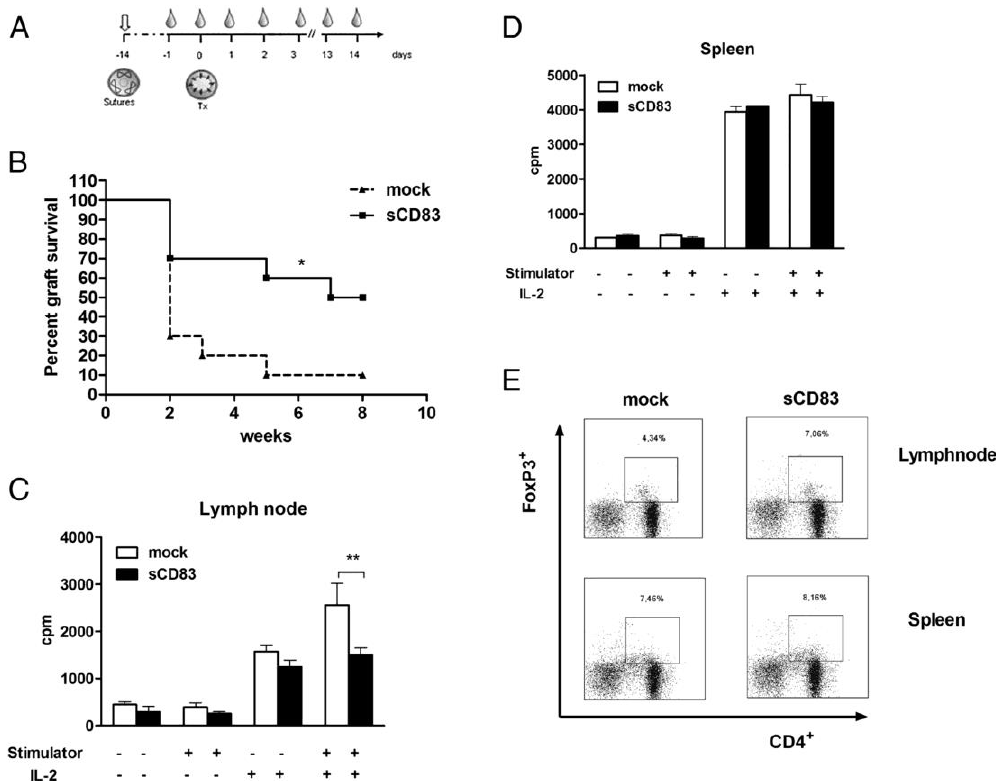
Figure 1. Topical application of sCD83 induces allogeneic graft tolerance, reduces proliferative response to donor alloantigen, and induces Foxp3 + regulatory T cells. ( A ) Experimental design and timescale of sCD83 administration. Sutures were placed in the cornea to induce inflammation (sutures) 14 d prior to transplantation (Tx). sCD83 (7.5 mg per 3 mL) was applied in the form of eye drops three times per day on indicated time points (drops). ( B ) The topical sCD83-treated group had a significantly improved graft survival compared with the mock-treated group ( p < 0.025; number of animals in each group: n = 10). * p < 0.05. ( C ) Draining lymph node cells from sCD83-treated animals showed a significantly reduced proliferation capacity in the presence of alloantigen and IL-2 compared with the mock-treated animals. Cells derived from sCD83-treated animals were still able to respond to exogenous IL-2, but to a lesser extent than mock-treated mice. Data are presented as the mean ± SE of triplicate samples. ( D ) This e ff ect could not be detected in restimulated splenocytes, neither in the sCD83- nor in the mock-treated group. ( E ) Single-cell suspensions of neck lymph nodes and spleens derived from di ff erent treatment groups were analyzed by FACS and gated on CD3 + lymphocytes. The proportion of CD4 + T cells expressing Foxp3 in the lymph node was increased in sCD83-treated animals in comparison with the mock-treated group (upper panel). Again, this e ff ect could not be observed in the spleen (lower panel). Representative FACS plots are shown. The experiment represents the data of cells from five pooled mice. ** p < 0.01